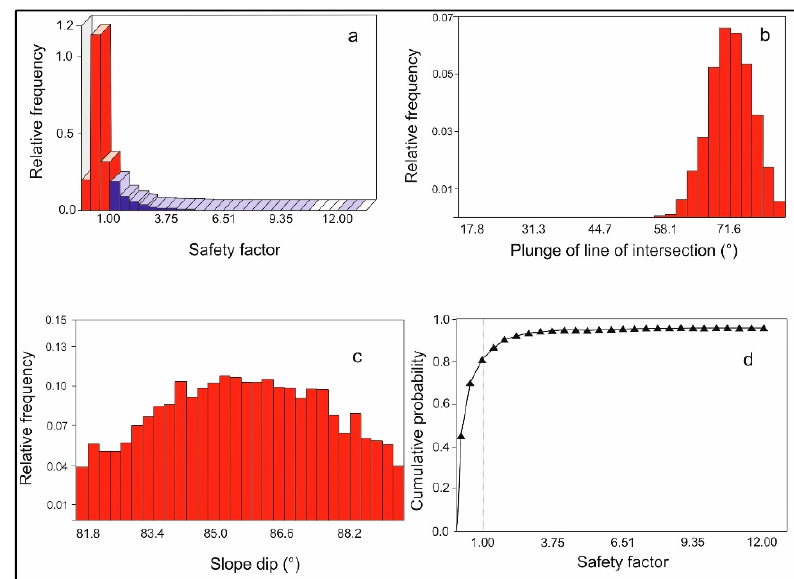
Figure 10. Results of the probabilistic analysis for wedge failures. Key: ( a ) histogram showing the distribution of safety factor, for all valid wedges generated by MC of the input data. The red bars represent blocks with SFs less than 1.00; ( b ) relative frequency distribution of failed wedges vs. the variation of the plunge of the line of intersection dip; ( c ) relative frequency distribution of failed blocks vs. the variation of the slope angle; ( d ) cumulative safety factor distribution giving the probability that SF will be less than or equal to the value of the variable at that point. Number of simulations = 10,000.